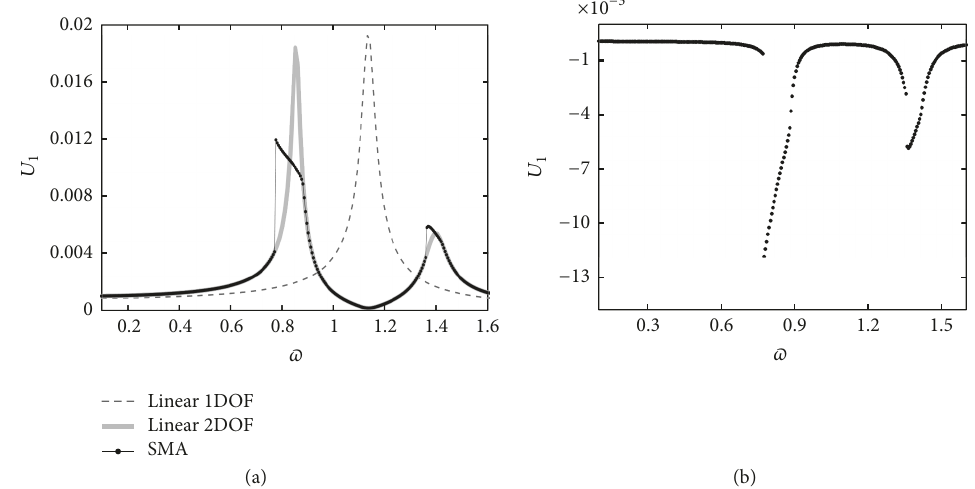
Figure 3: Primary system response with 𝛿 = 0.0011 and 𝛾 𝑚 = 0.22 in down-sweep test: (a) maximum amplitude; (b) bifurcation diagram.